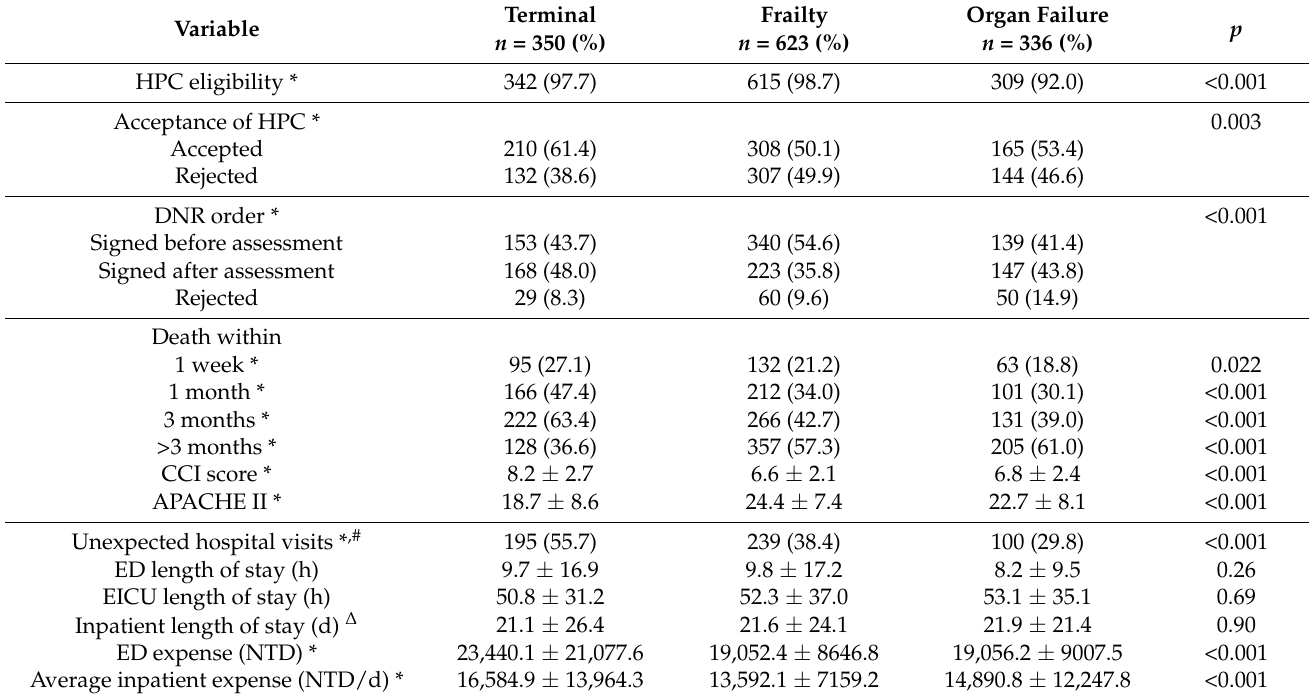
Table 2. Comparison of different end-of-life trajectories by patient clinical and HPC-related